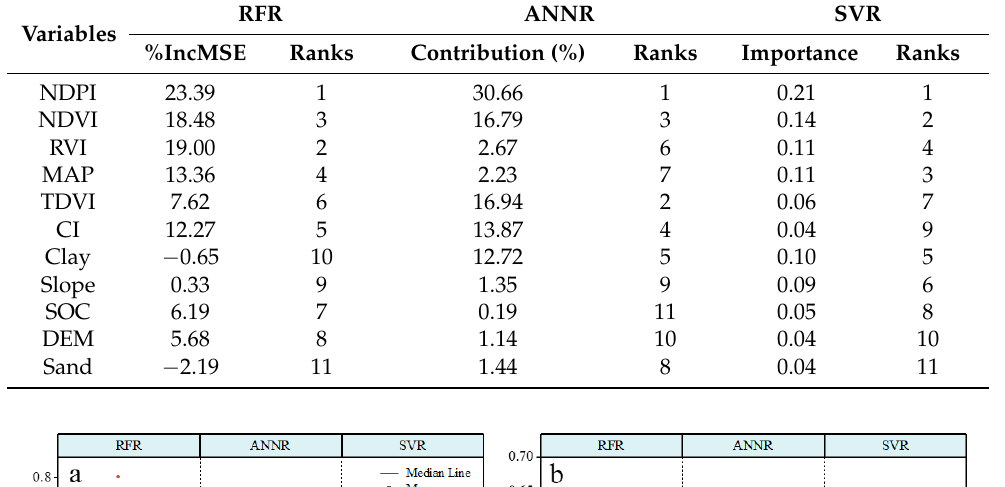
Table 2. Ranking of variable importance based on the RFR, ANNR and SVR. Results are ranked according to the summation of the three methods of sorting for each variable.